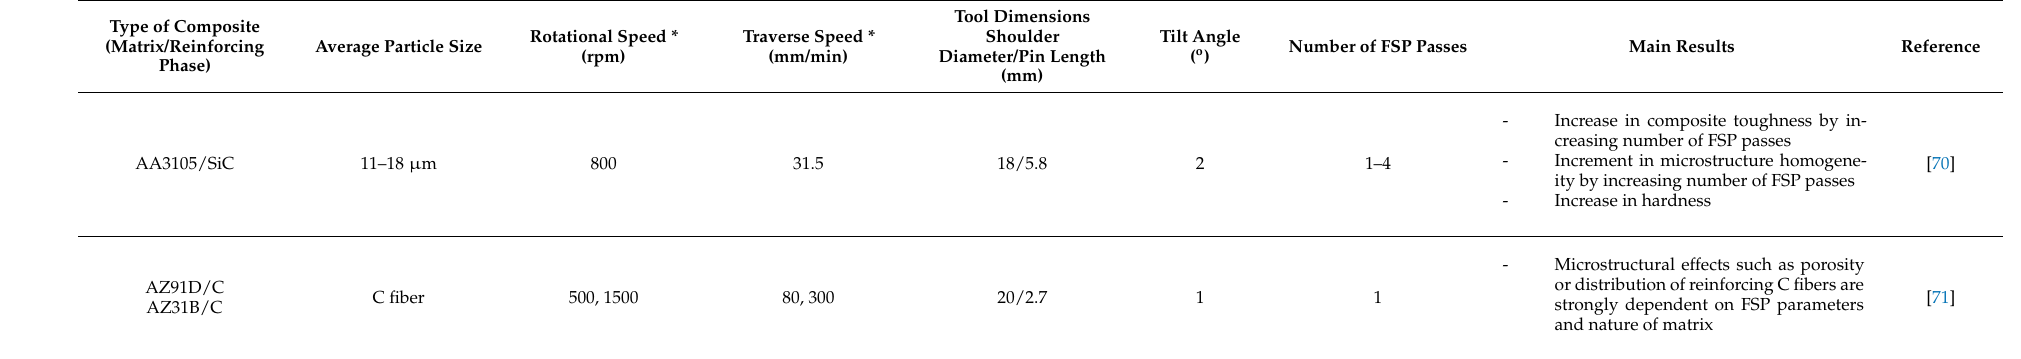
Table 3. List of cited